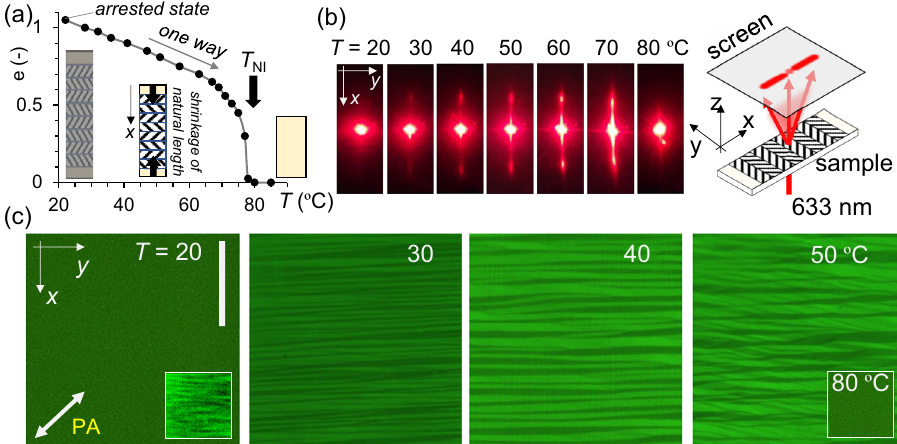
Fig. 3 Effects of thermal annealing on the arrested LCE. a Natural length shrinkage of the arrested LCE with increasing annealing temperature. The sample uniaxially contracts irreversibly and the original shape is recovered upon crossing T NI . b Evolution of light-scattering (LS) patterns (633 nm) of non- polarized light without an analyzer. The fi rst diffraction peaks increase in intensity with temperature and disappear at T NI . c Polarized fl uorescence optical microscopy (PFOM) images obtained under identical conditions at different temperatures, showing stripe patterns with their wave vector in the x -direction. The insets in the image acquired at 20 and 80 °C show a contrast-enhanced version with visible blurred stripes and absence of stripes,